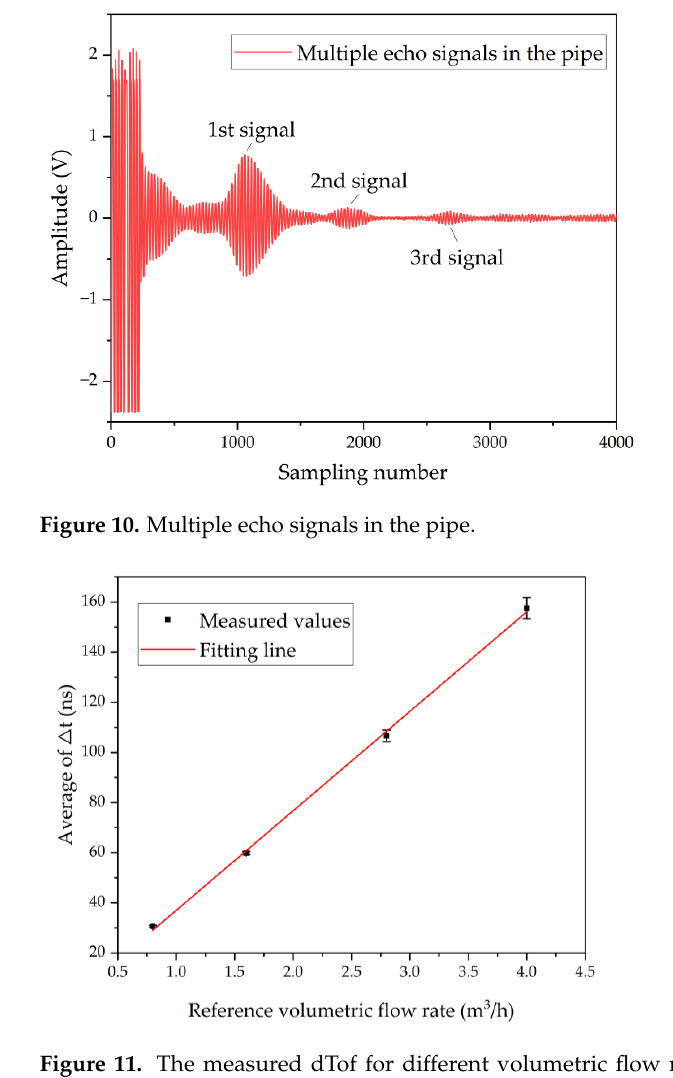
Figure 11. The measured dTof for different volumetric flow rates and the fitting line show the linear